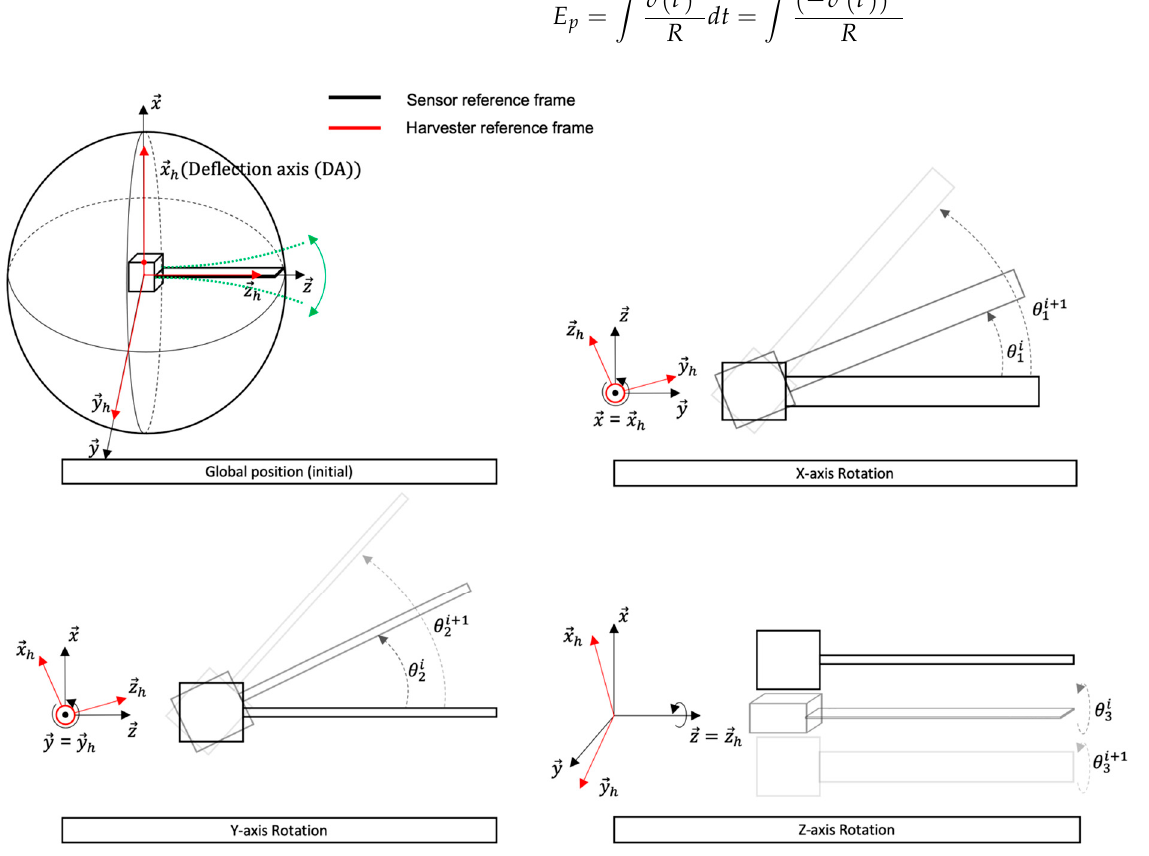
Figure 3. Harvester orientation in Cartesian space. The rotation around the 𝑥⃗ (cid:3035) -axis (de fl ection) does not impact the de fl ection direction. The harvested energy is not impacted.